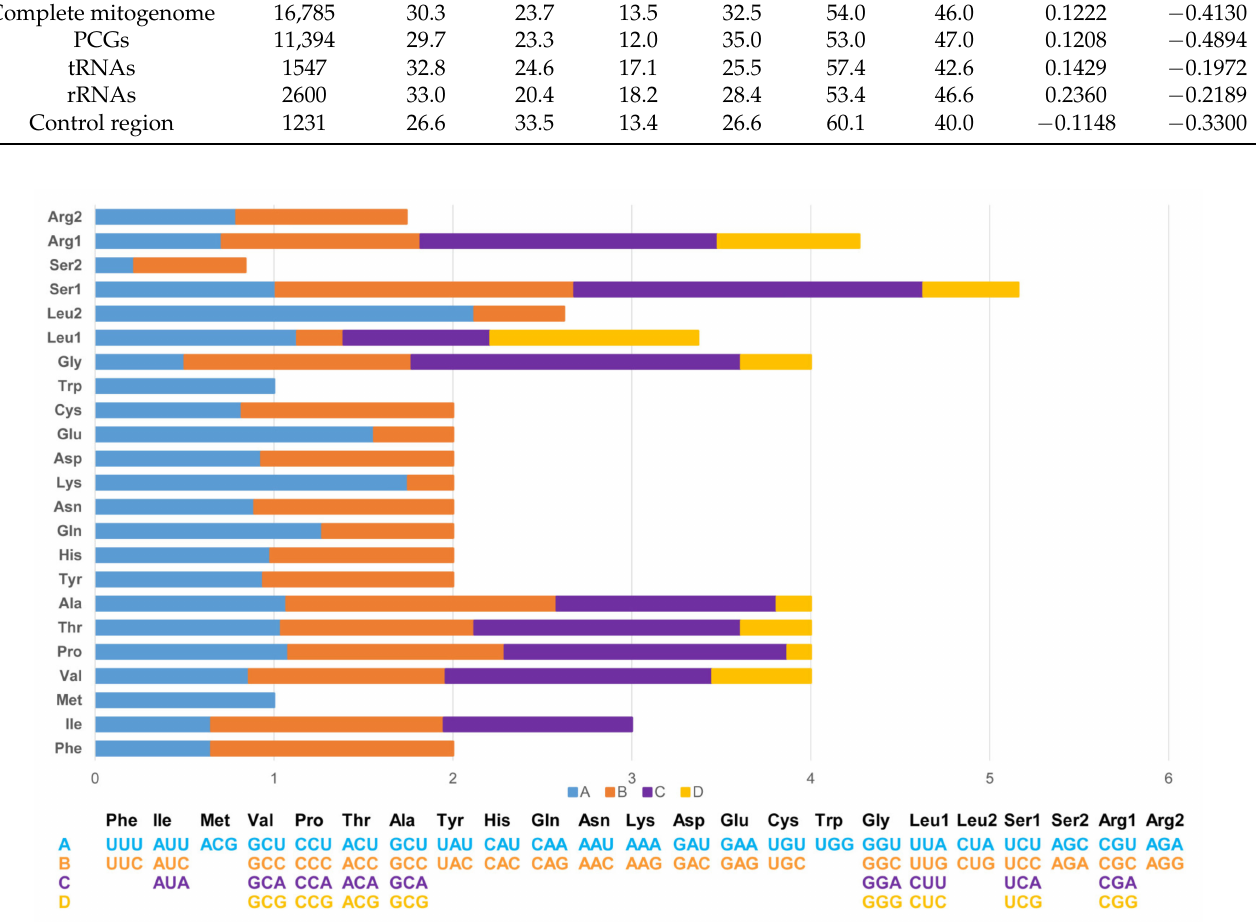
Figure 3. Relative synonymous codon usage (RSCU) in the Pingpu Yellow chicken mitochondrial